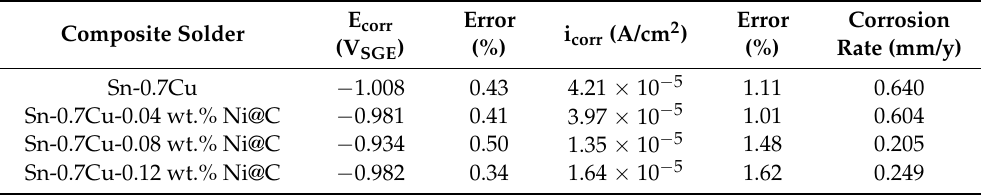
Table 1. Corrosion parameters of Sn-0.7Cu-xNi@C ( x = 0, 0.04, 0.08, 0.12 wt.%) composite